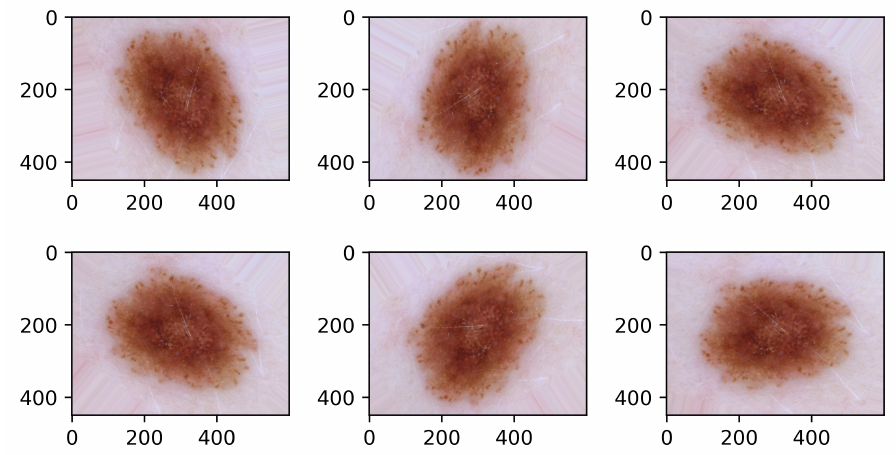
Figure 4. The generated image sample uses the augmented